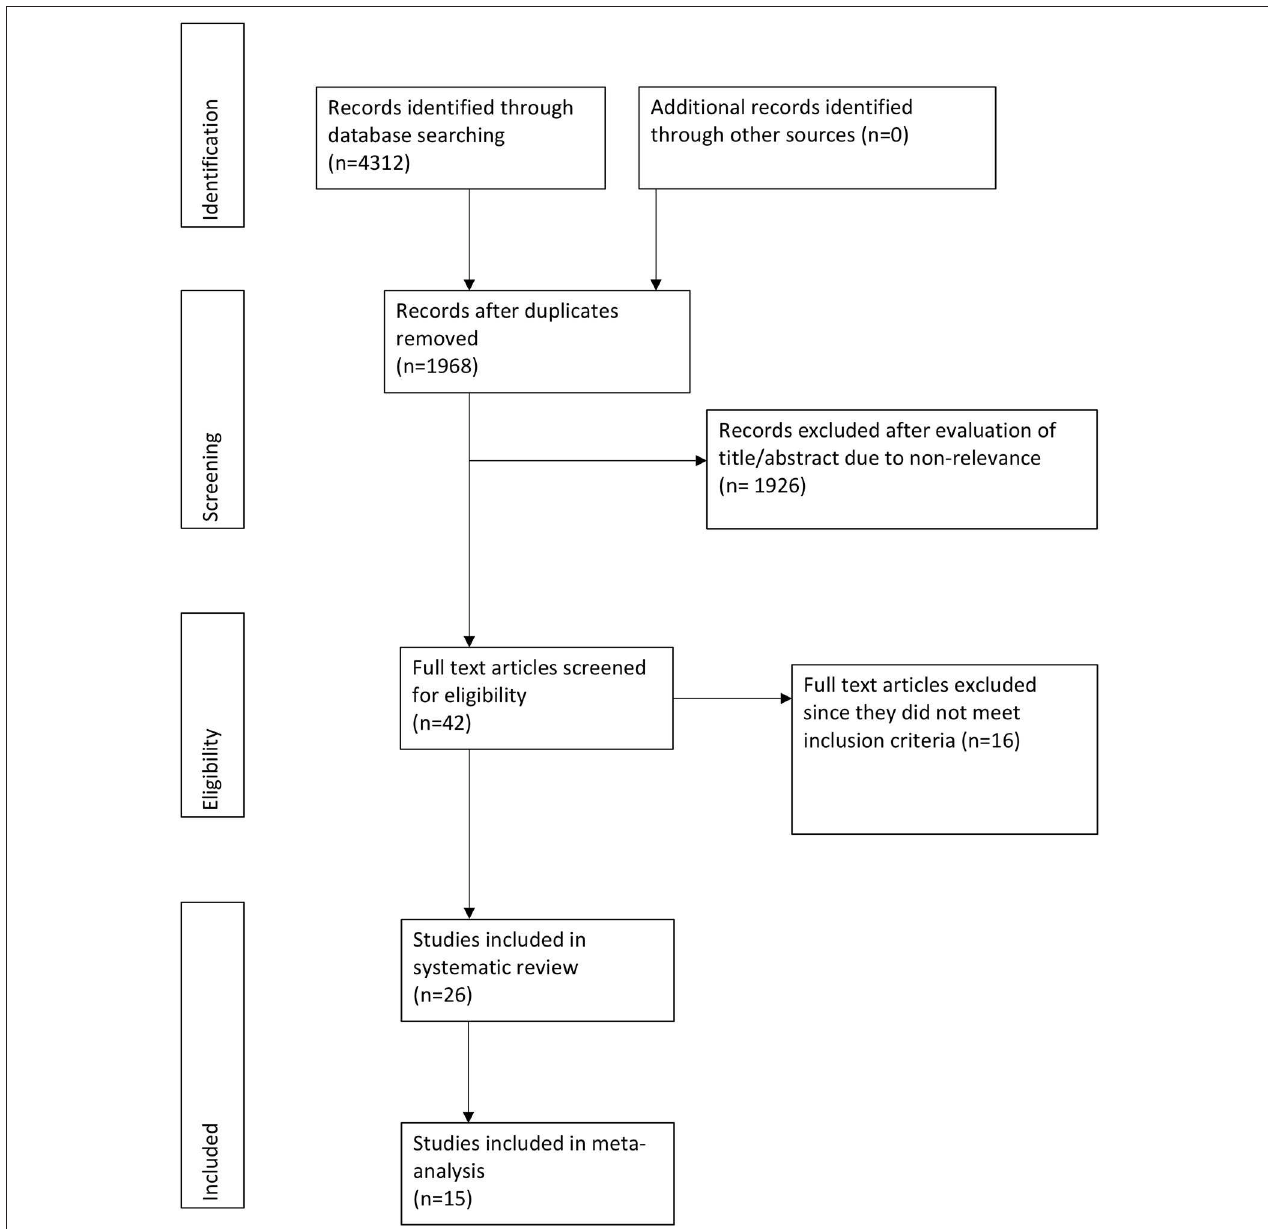
FIGURE 1 | Flowchart of